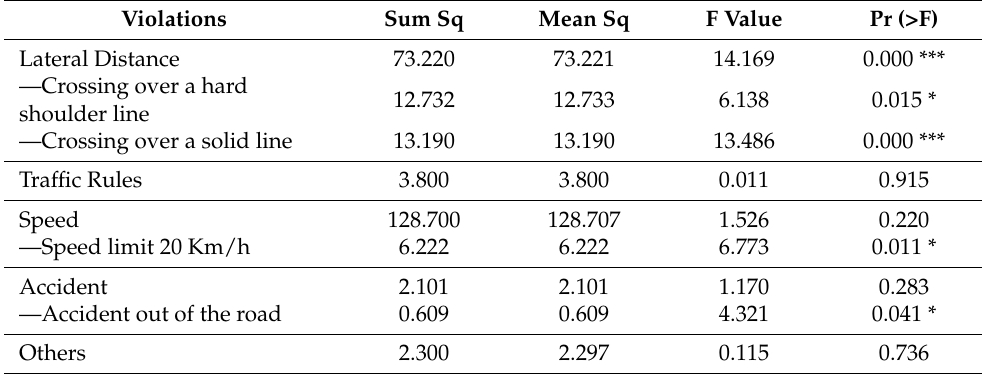
Table 2. ANOVA test for the number of